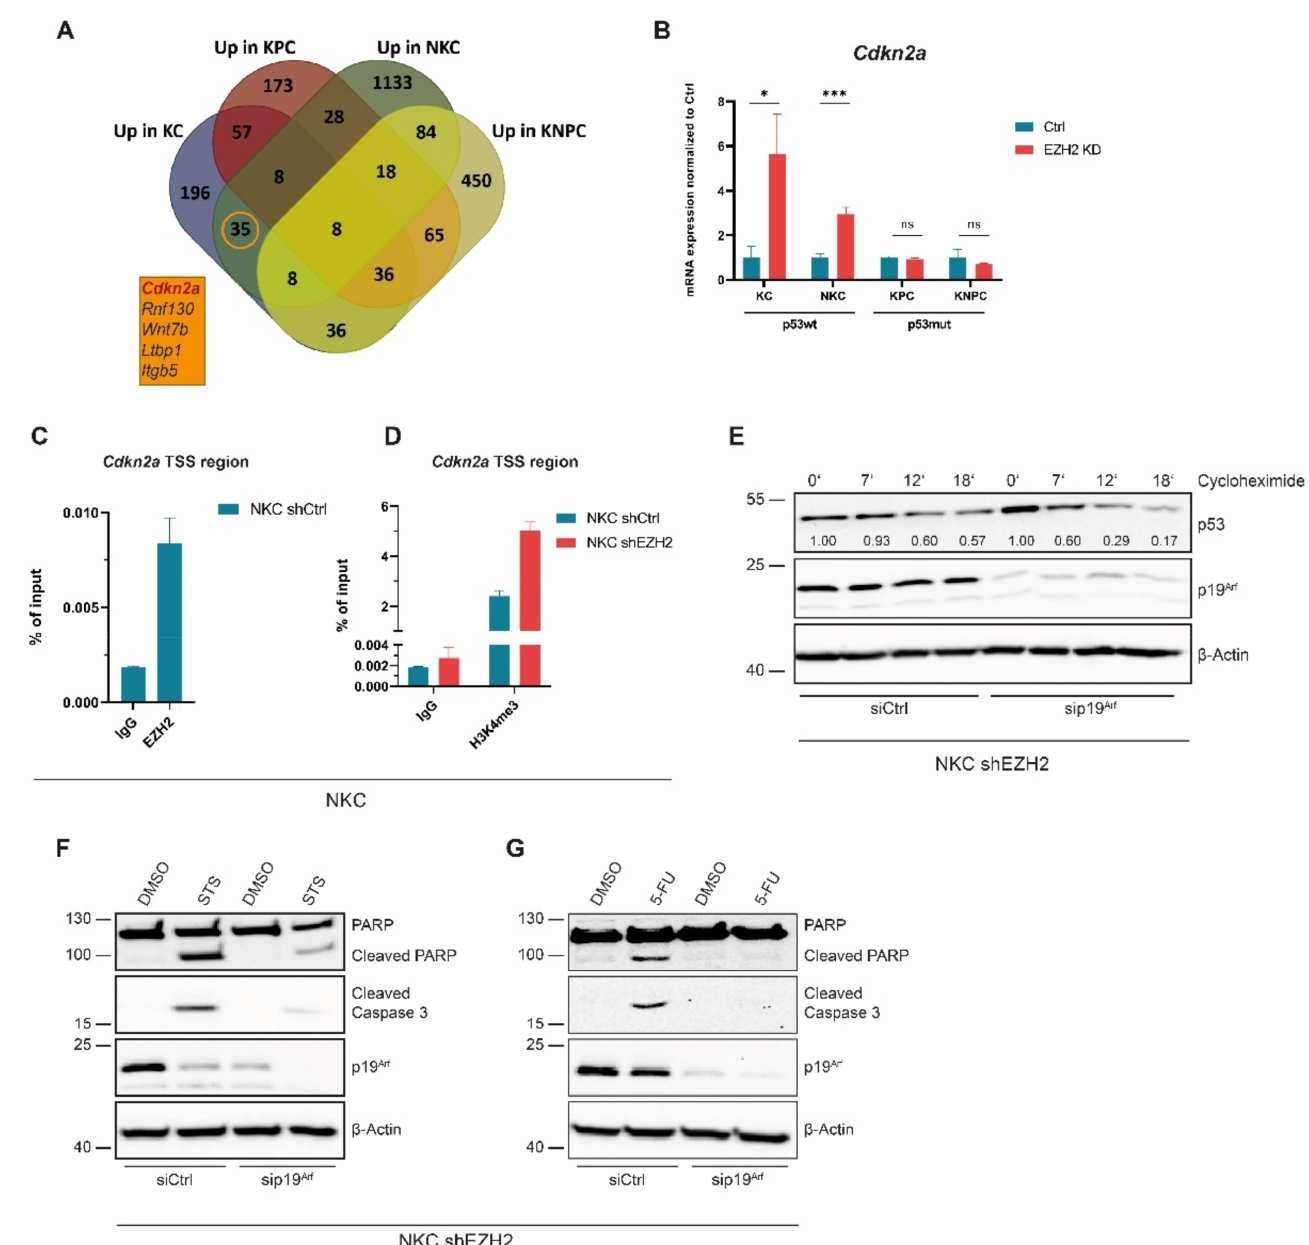
time-points of cycloheximide treatment are normalized to the respective basal (0 (cid:48) ) p53 levels, which have been set to 1.00. ( H ) Short-term treatment with the proteasome inhibitor MG132 and subsequent western blot analysis to analyze ubiquitination of p53.